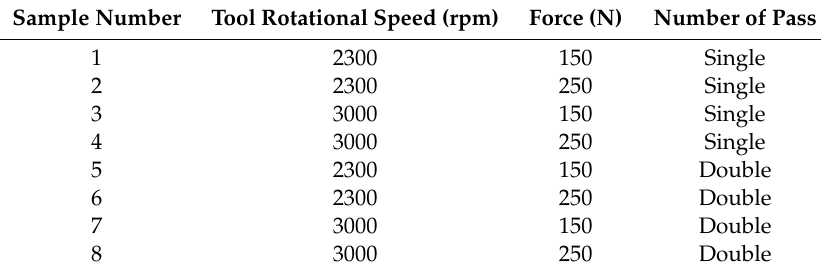
Table 3. Process parameters of the